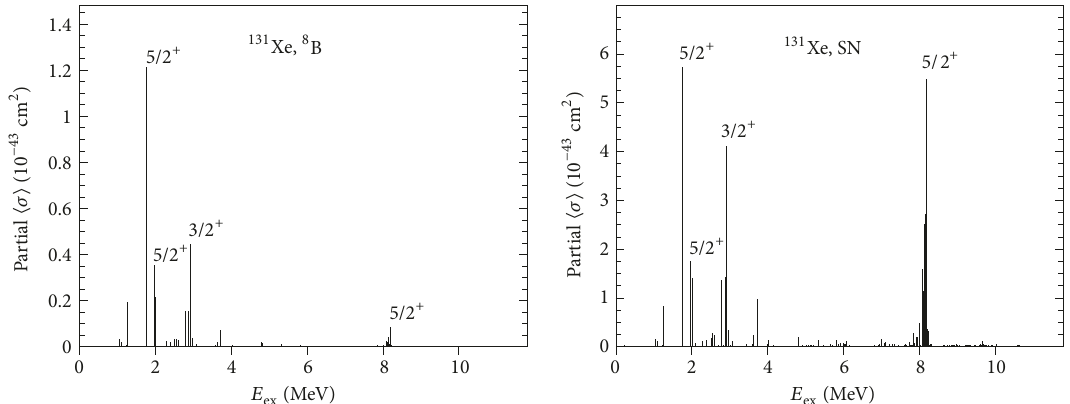
Figure 7: Contributions to the inelastic scattering averaged cross section arising from various final states of 131 Xe at energies 𝐸 shown for 8 B solar neutrinos (left panel) and supernova electron neutrinos (right panel). In both panels cross sections are given in units of 10 −43 cm 2 .